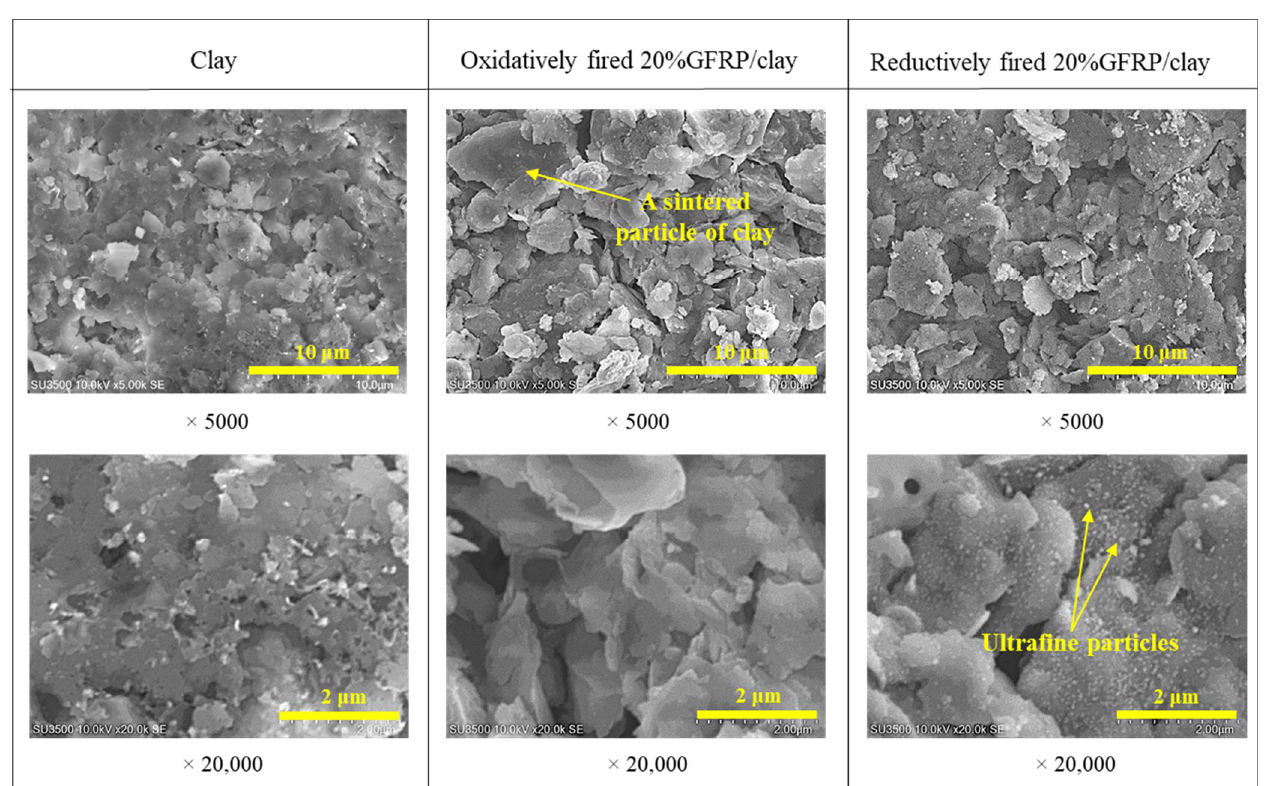
Figure 5. SEM images of the surface structures of clay and GFRP/clay ceramic samples.